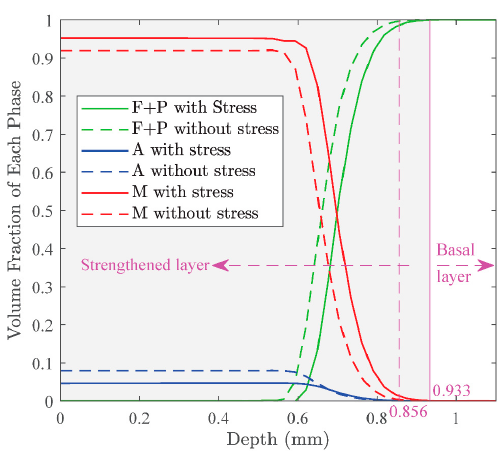
Figure 13. E ff ect of stress on the microstructure distribution and thickness of the strengthened